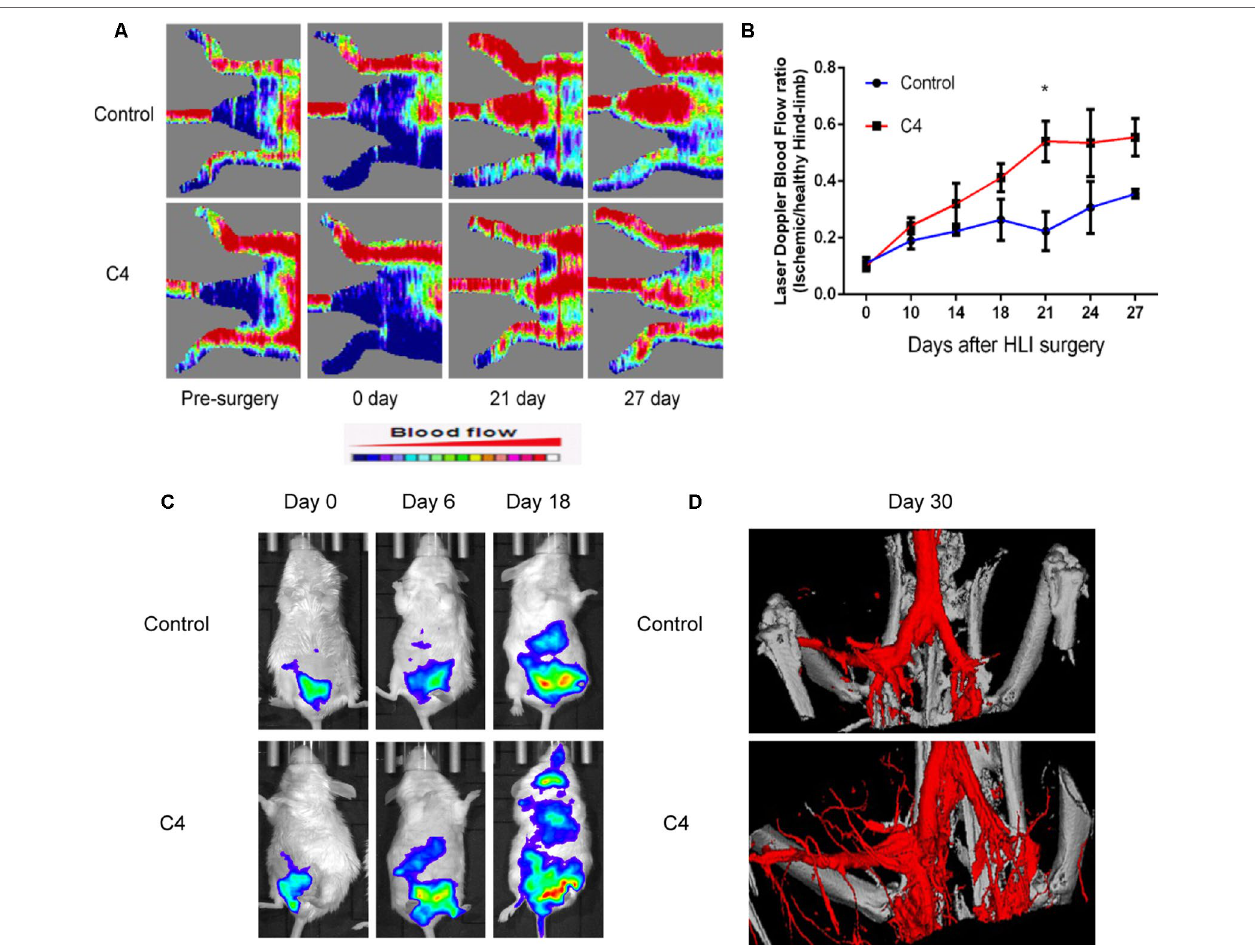
FIGURE 8 | DHI-C4 improved perfusion of ischemic limbs and enhanced local angiogenesis in ischemic mice in vivo . (A) Representative images of laser Doppler perfusion analysis for control mice and mice treated with DHI-C4 before surgery and at different time points after surgery (n = 3). (B) The mean hindlimb blood flow was calculated as the ratio of ischemic side to non-ischemic side. DHI-C4 significantly improved perfusion recovery after HLI surgery at 21 days. *P < 0.05 , DHI-C4 group compared with the control group. (C) Representative bioluminescent images of VEGFR-2-Luc mice after HLI were obtained at 18, 21, and 27 days under the same imaging conditions. (D) Representative images of micro-CT reconstructed 3D microangiography of the defect areas (n =